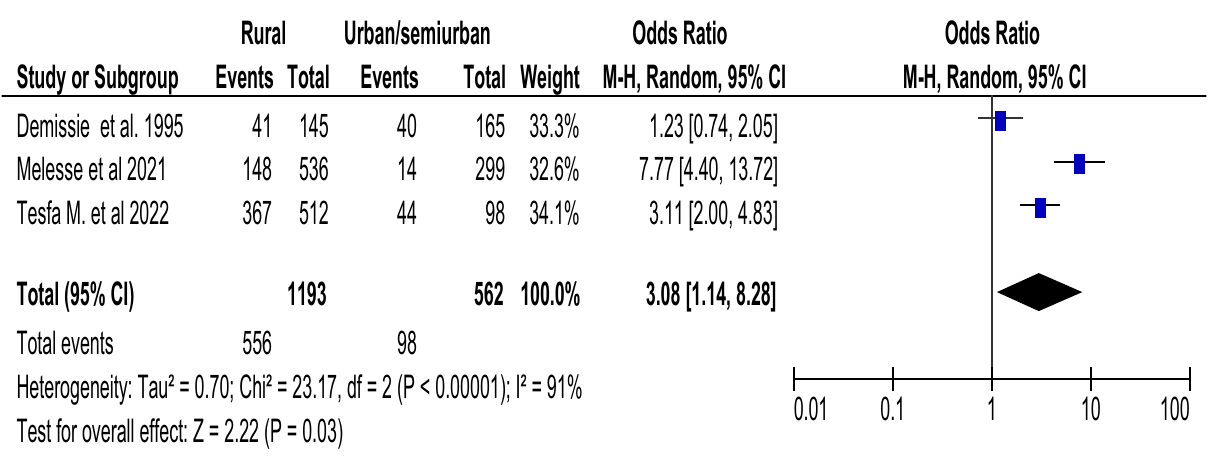
Figure 10. Association between place of residence and food taboo practices among pregnant women in Ethiopia, 2022